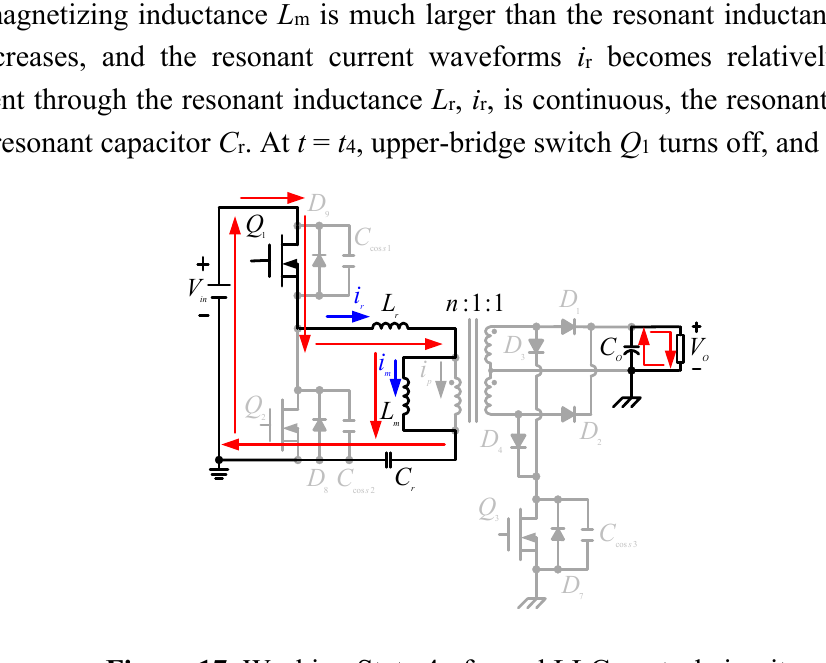
Figure 17. Working State 4 of novel LLC control